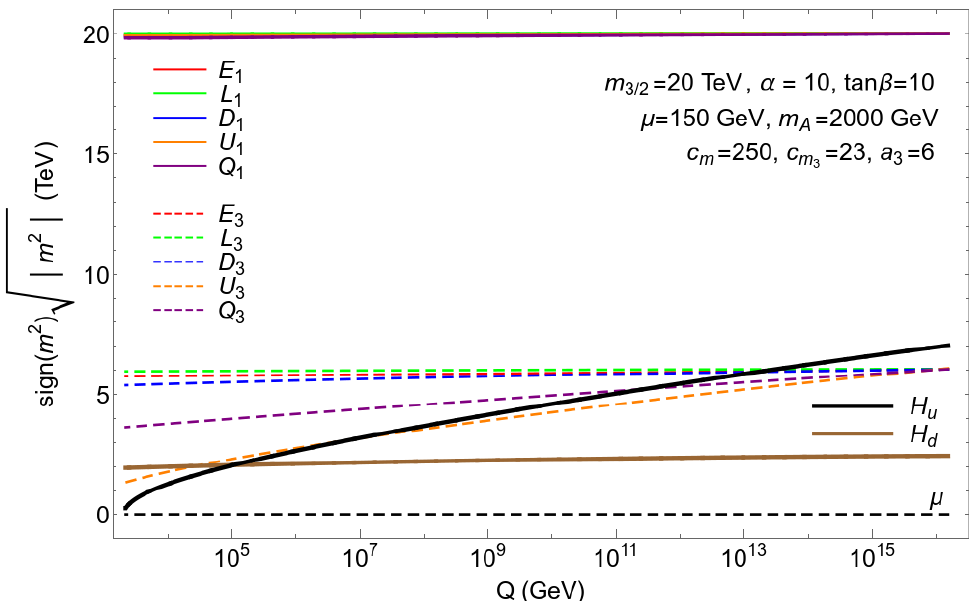
Figure 9 . Plot of running scalar masses from the mini2 benchmark point with m (cid:11) = 10, tan (cid:12) = 10 and c m = 250, a 3 = 6 with c m 3 = 23, (cid:22) = 150 GeV and m A = 2 TeV at the weak scale.